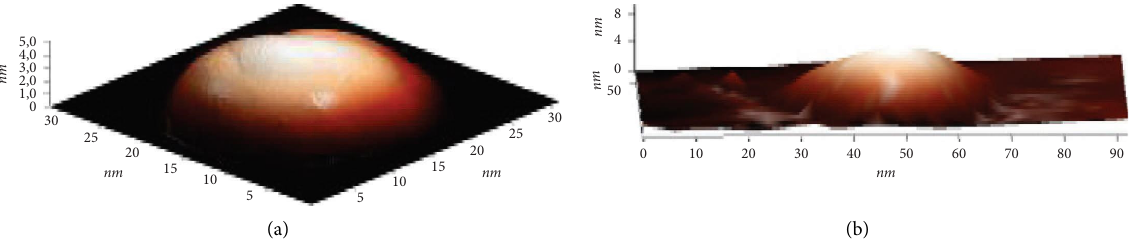
Figure 2: SPM images of micro- (a) and nanodroplets (b) of Au-catalyst on the surface of Si-plate with crystallographic orientation {111}.